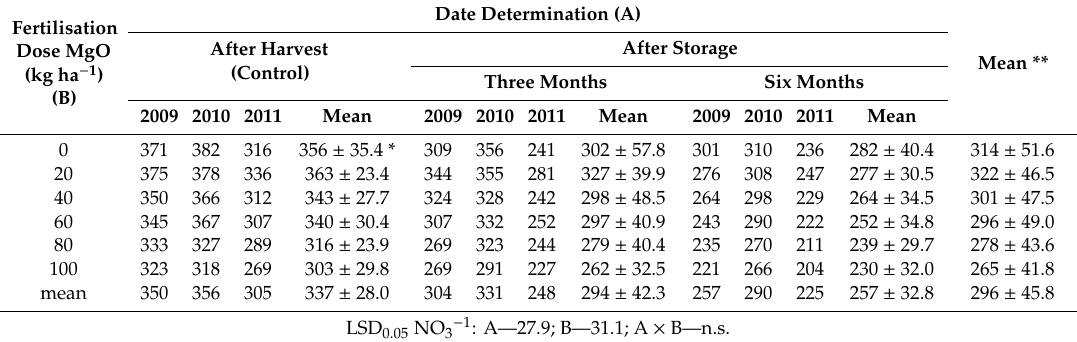
Table 3. The nitrate contents in potato tubers (mg kg − 1 FW) depending on Mg fertilization and date of